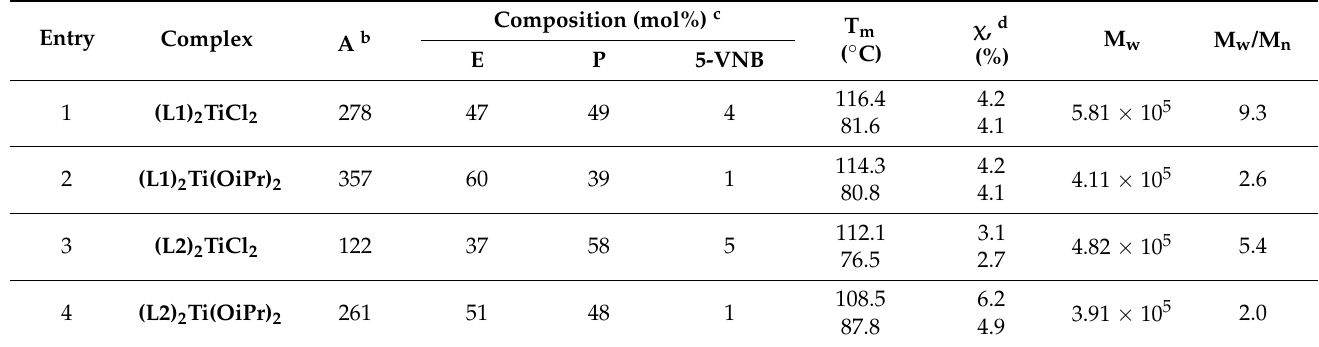
Table 4. Ethylene/Propylene/5-ethylidene-norbornene copolymerization a